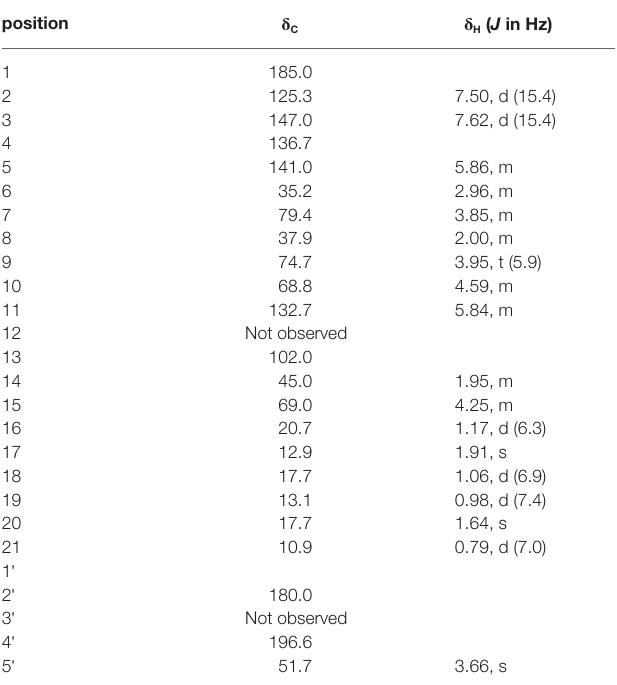
TABLE 1 | 1 H and 13 CNMR spectroscopic data measured in MeOD for nocamyin F.